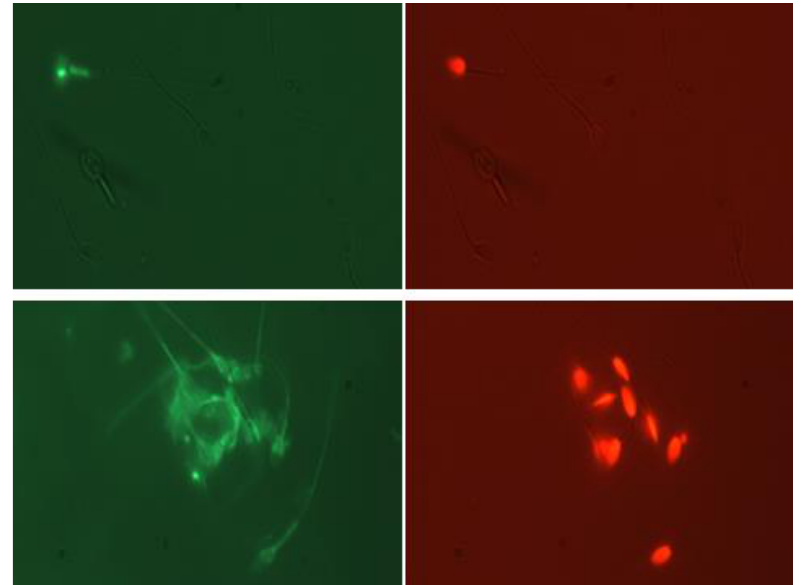
Figure 6. Visible light combined with a fluorescent microscopic image (400× magnification) of spermatozoa stained with DayLight488 (NeutrAvidin fluorescent conjugate; left panel) of the same sperm shown with PI staining (right panel). Non-treated (mostly viable sperm; upper panel) and snap-frozen (nonviable sperm; lower panel) showing PI+ sperm to be LF+; note that sperm that were PI- were predominately LF- (upper panel).